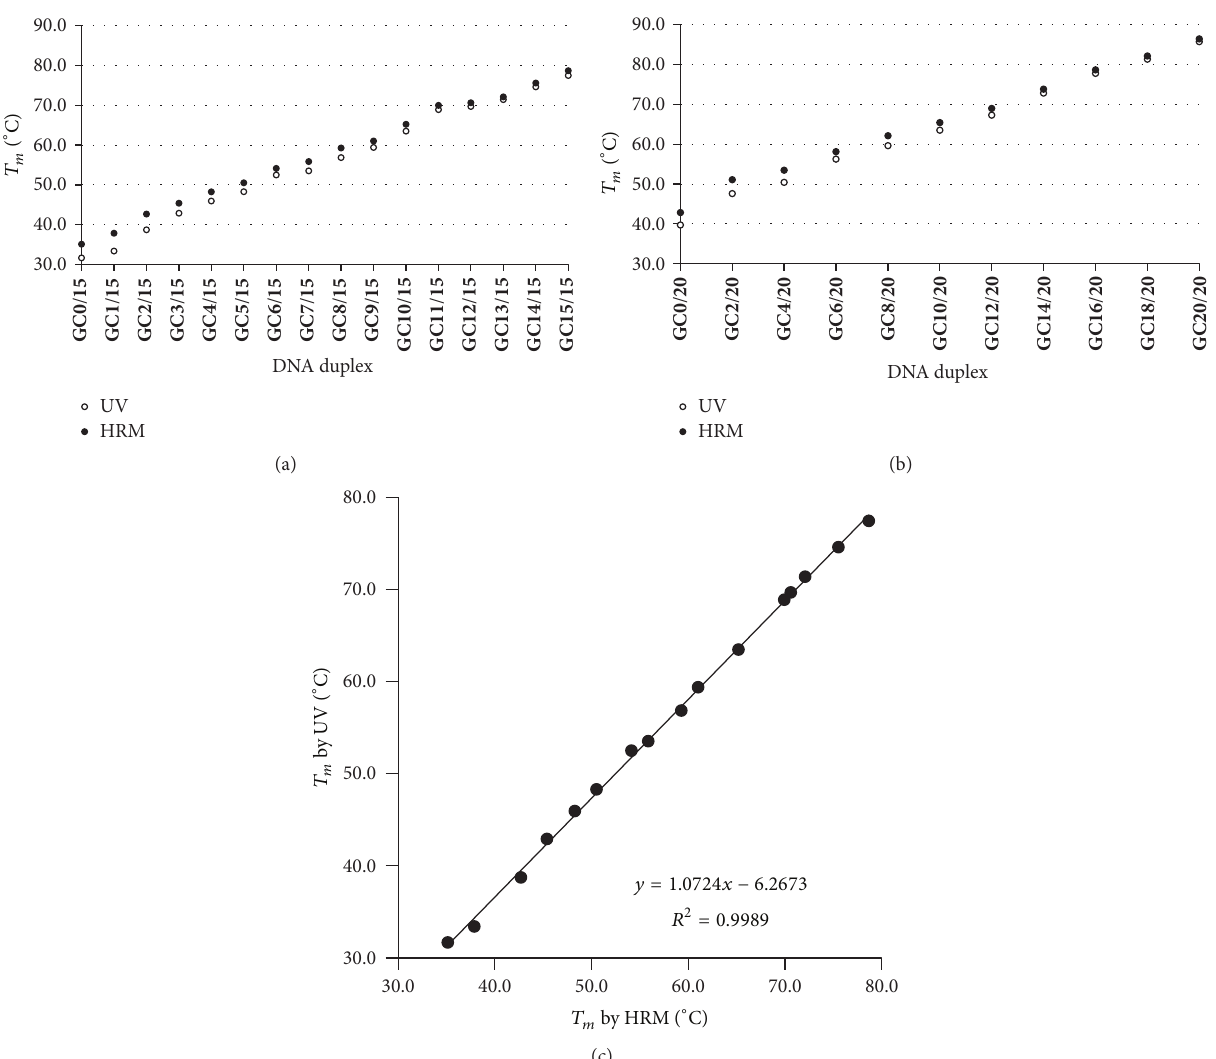
Figure 3: Comparison of 𝑇 𝑚 values of DNA duplexes measured by HRM and UV melting method. 𝑇 𝑚 s of 15bp (a) or 20bp (b) DNA duplexes were measured, and the linear relationship between 𝑇 𝑚 s of 15 bp DNA duplexes by HRM and UV was obtained